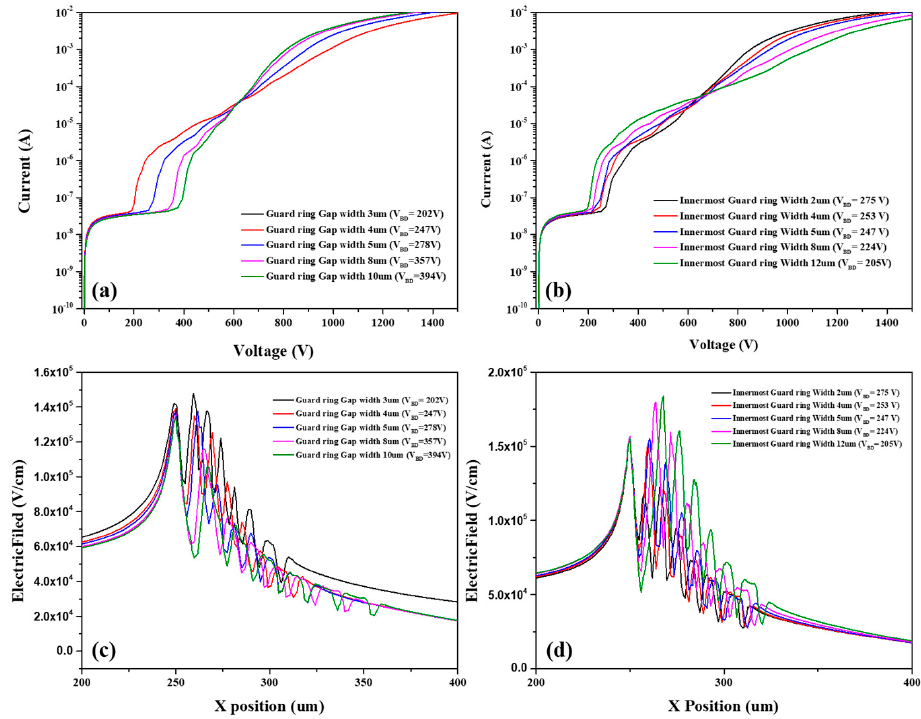
Figure 7. The simulated I–V curve breakdown voltage of c-SSBD is influenced by guard ring design: ( a ) spacing between the innermost guard ring and the active area, ( b ) innermost guard ring width, the electric field distribution of ( c ) spacing between the innermost guard ring and the active area, ( d ) innermost guard ring width.